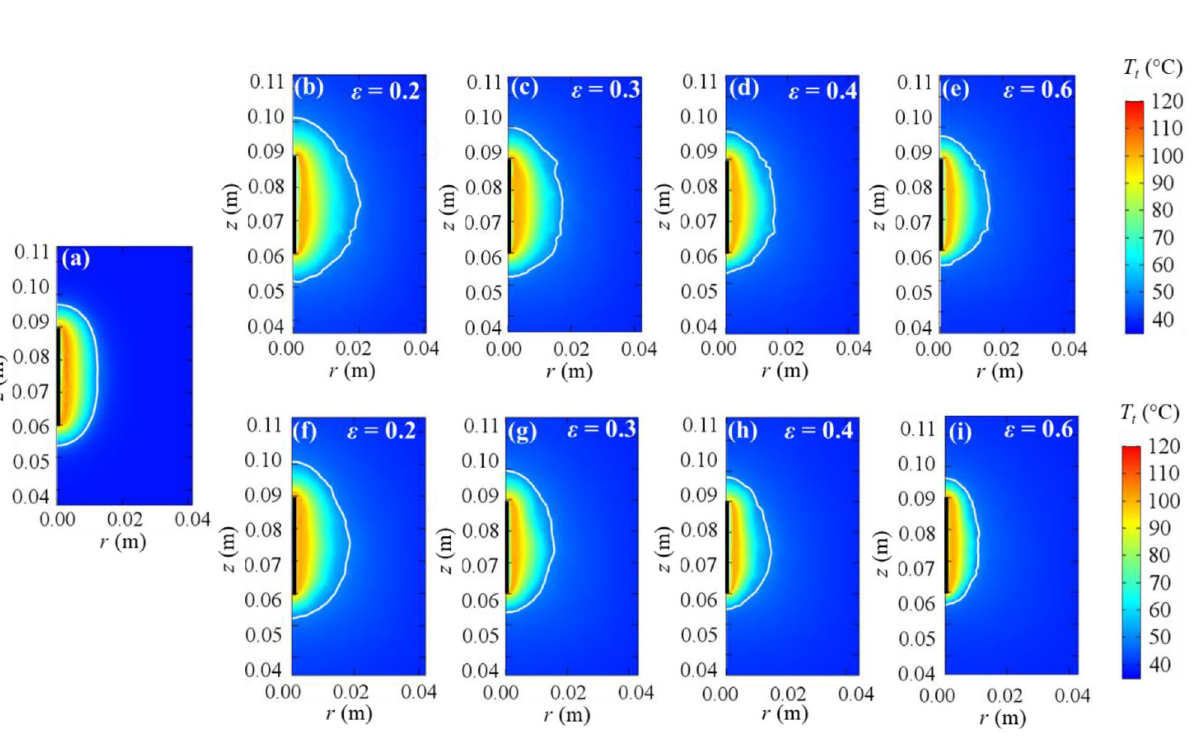
Figure 3. Tissue temperature distributions after 720 s of applying 65 V computed from Pennes’ bioheat model ( a ), LTE model ( b – e ), and LTNE model ( f – i ) for different porosities ( ɛ ). White line represents coagulation zone contour. The thicker black line identifies the position of the